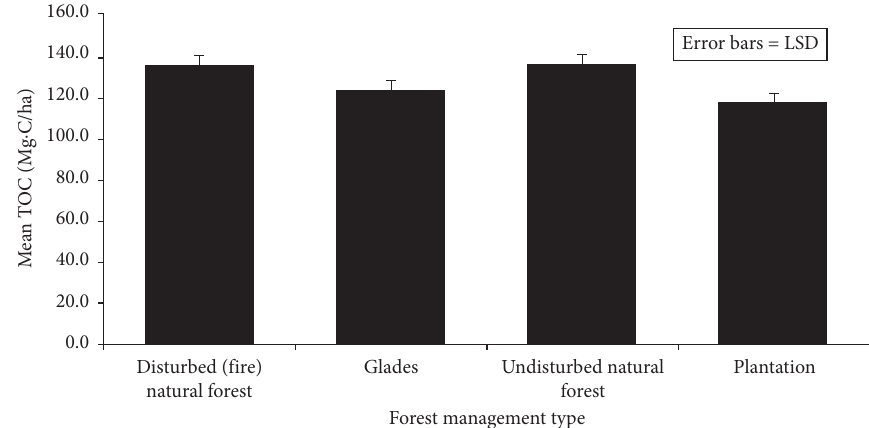
Figure 2: Soil carbon stocks under different forest management types.